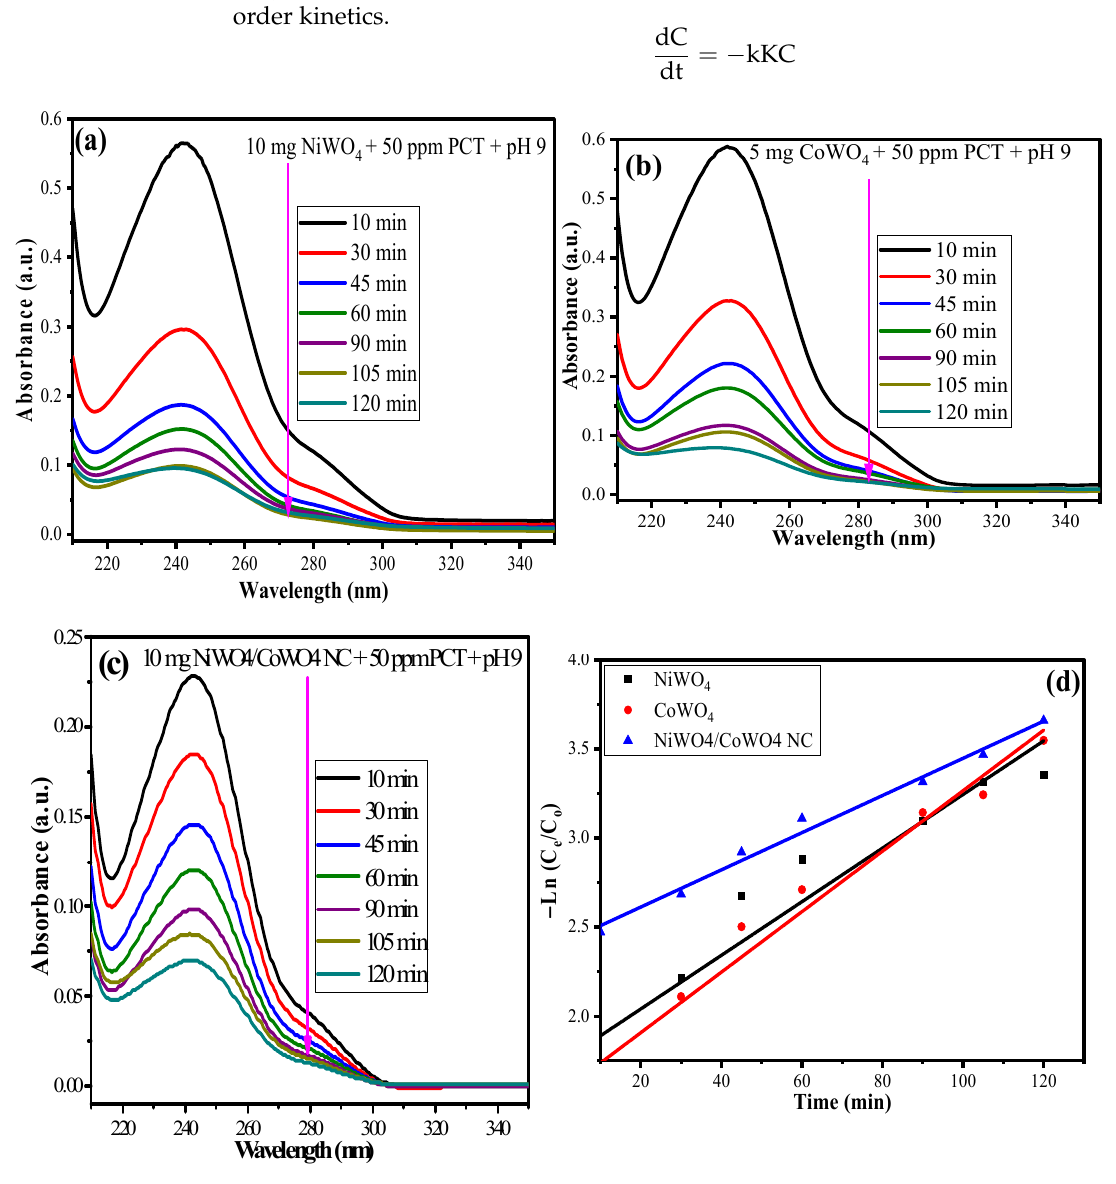
Figure 10. Effect of variable UV irradiation time (10–120 min) using 50 ppm PCT and 10 mg of ( a ) NiWO 4 , ( b ) CoWO 4 , ( c ) NiWO 4 /CoWO 4 NC, and ( d ) − Ln (C e /C o ) vs. time (min) pseudo first order plot. Table 2. Pseudo-first-order kinetic parameters for the photocatalytic degradation of paracetamol by synthesized NiWO 4 , CoWO 4, and NiWO 4 /CoWO 4 NC.